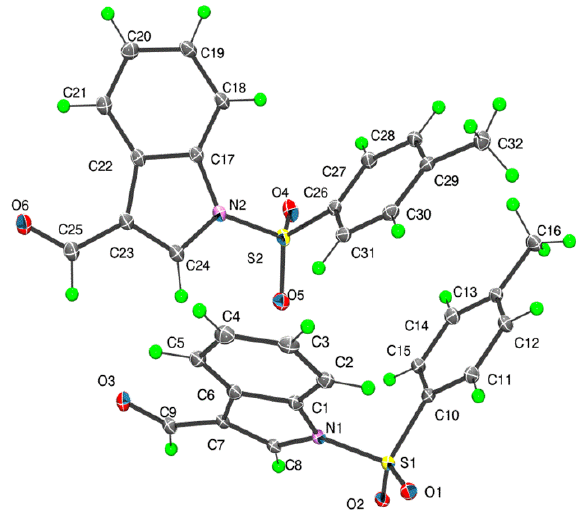
Figure 2. Molecular structures for the two independent molecules of 1 showing the atom numbering